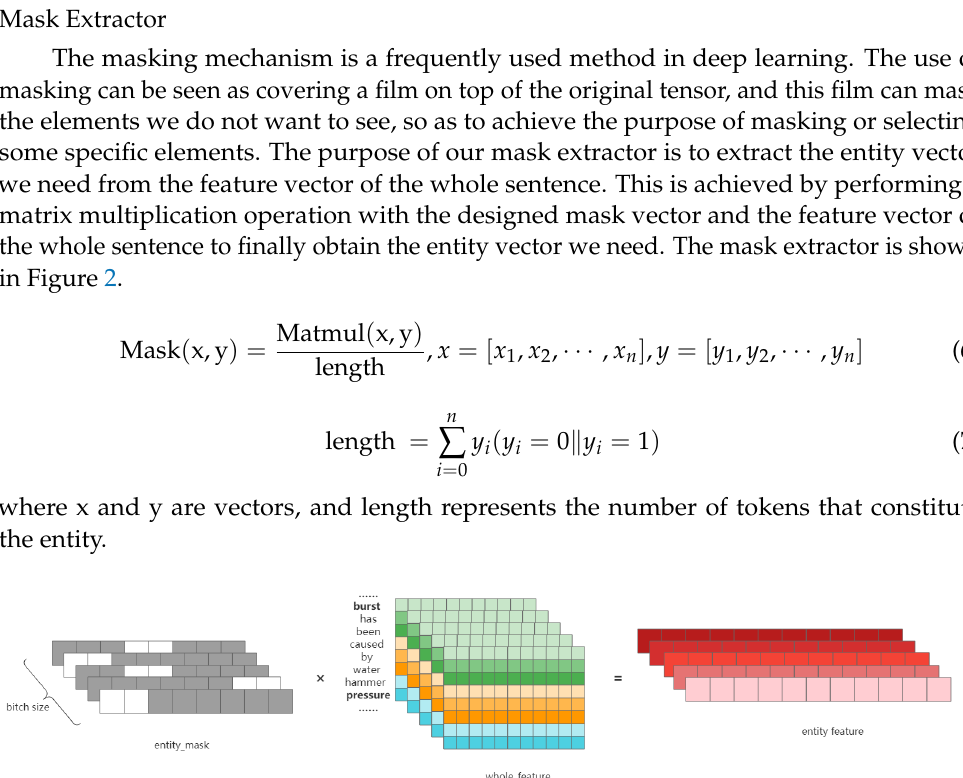
and whole feature mask